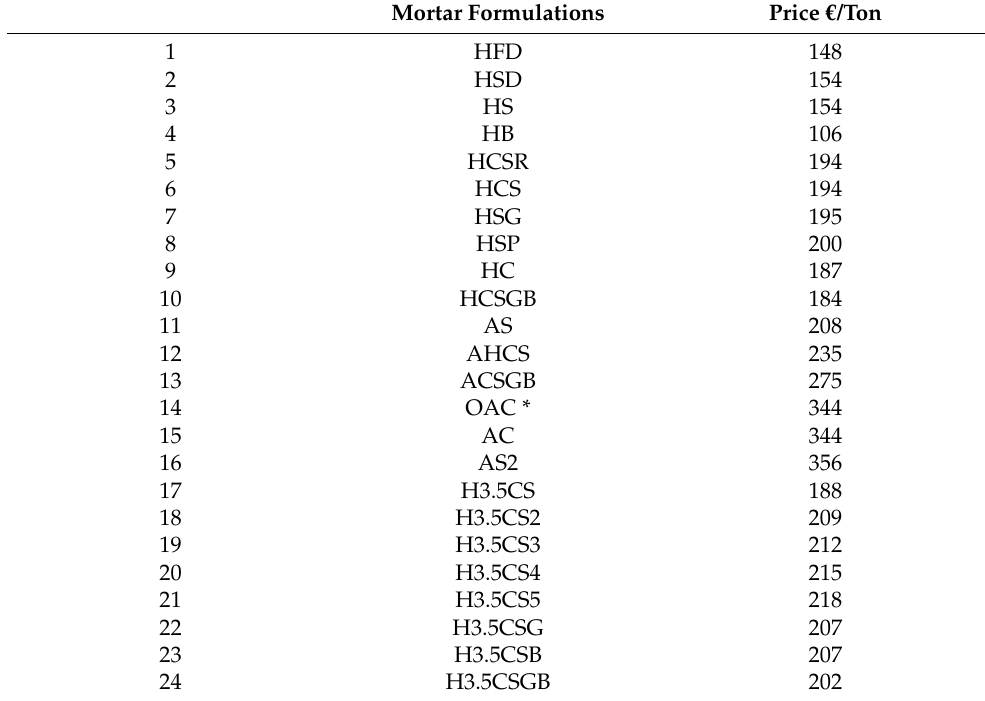
Table 9. Cost per ton ( € /t) of mortars.